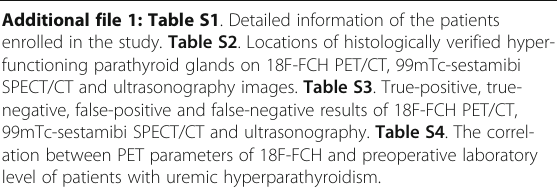
Additional file 1: Table S1 . Detailed information of the patients enrolled in the study. Table S2 . Locations of histologically verified hyper- functioning parathyroid glands on 18F-FCH PET/CT, 99mTc-sestamibi SPECT/CT and ultrasonography images. Table S3 . True-positive,